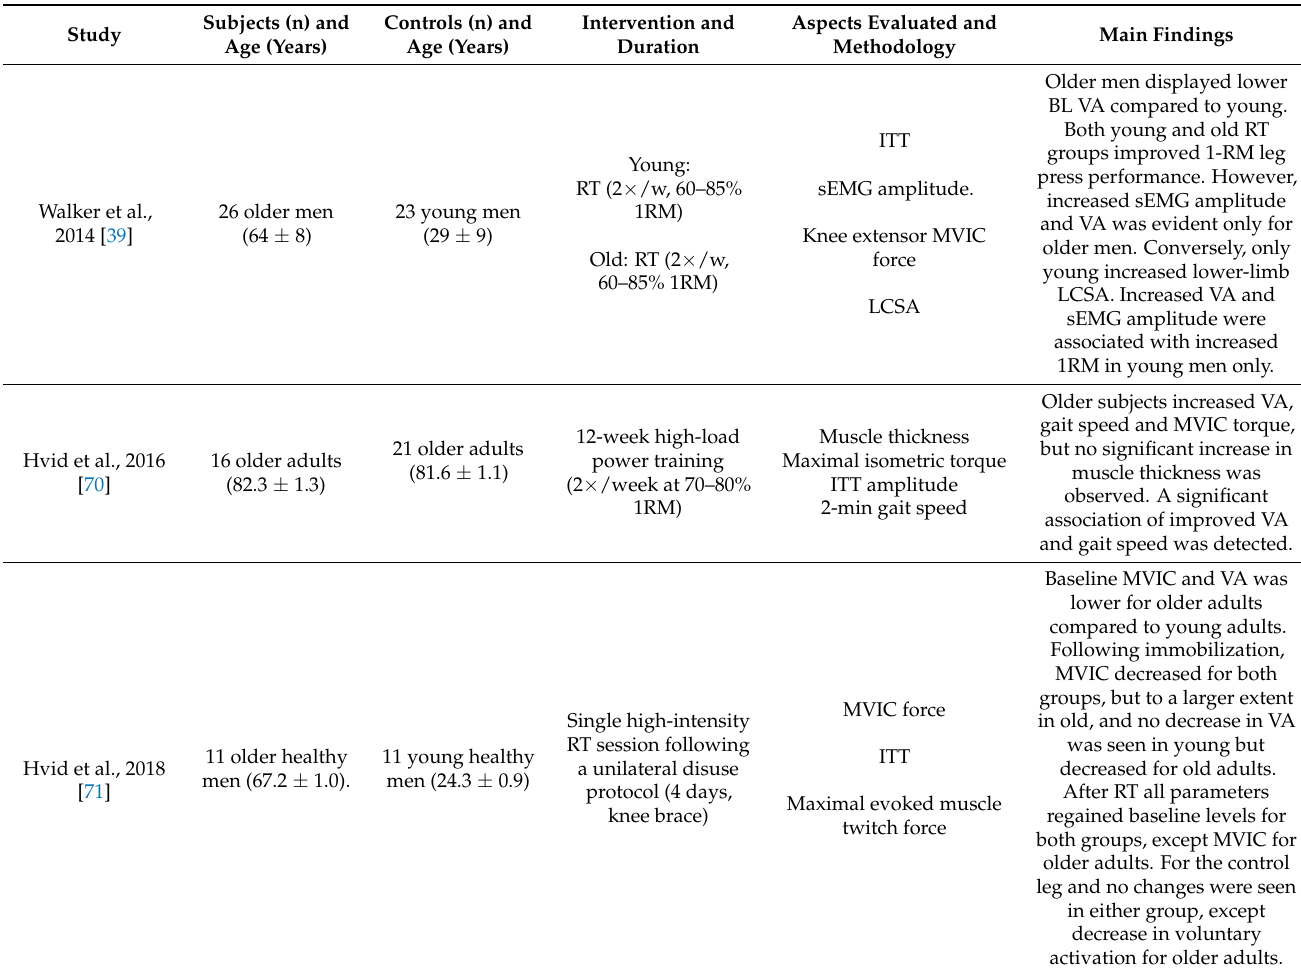
Table 5. Studies evaluating voluntary muscle activation using ITT or CAR separately or in combina- tion with the methodologies of I–IV, following RT in older